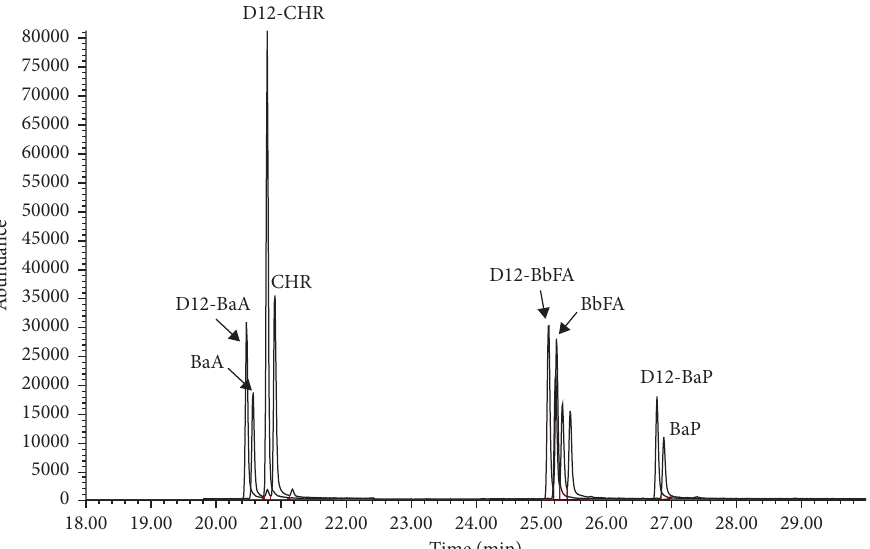
Figure 2: Ion chromatograph of PAH4 and the D12-PAH internal standards.